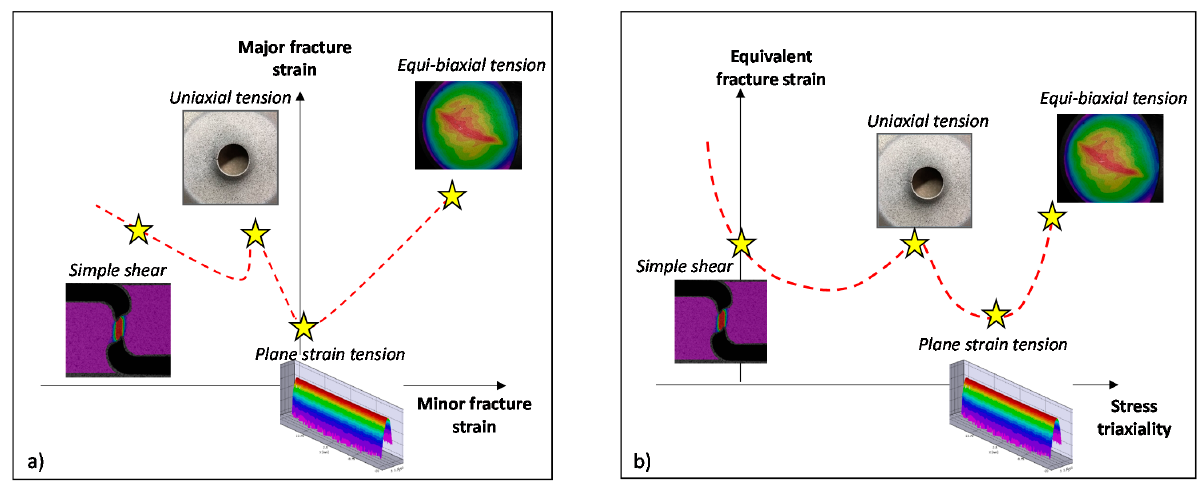
Figure 24. Overview of selected experimental program to characterize stress states ranging from simple shear to equi-biaxial tension, schematically illustrated in strain space ( a ) and stress space ( b ).